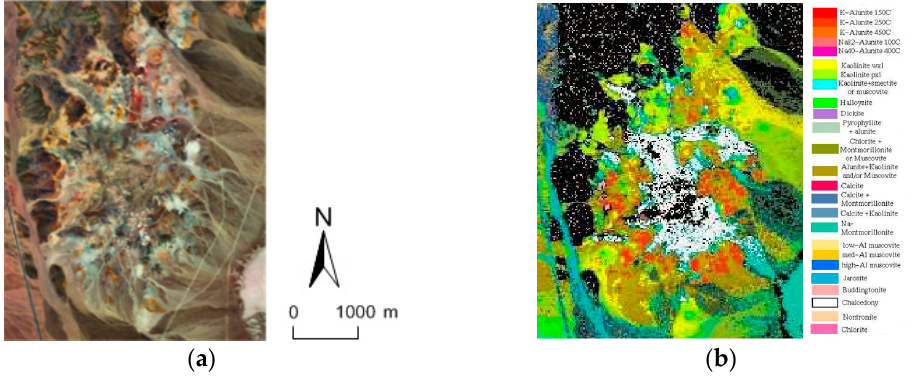
Figure 10. ( a ) Sub-image extracted from the Airborne Visible/Infrared Imaging Spectrometer (AVIRIS) Cuprite data and ( b ) reference map of the mineral distribution. Table 3. SAD values and their standard deviations (10 − 2 ) for different methods on the Cuprite data. The best result in each row is shown in bold.